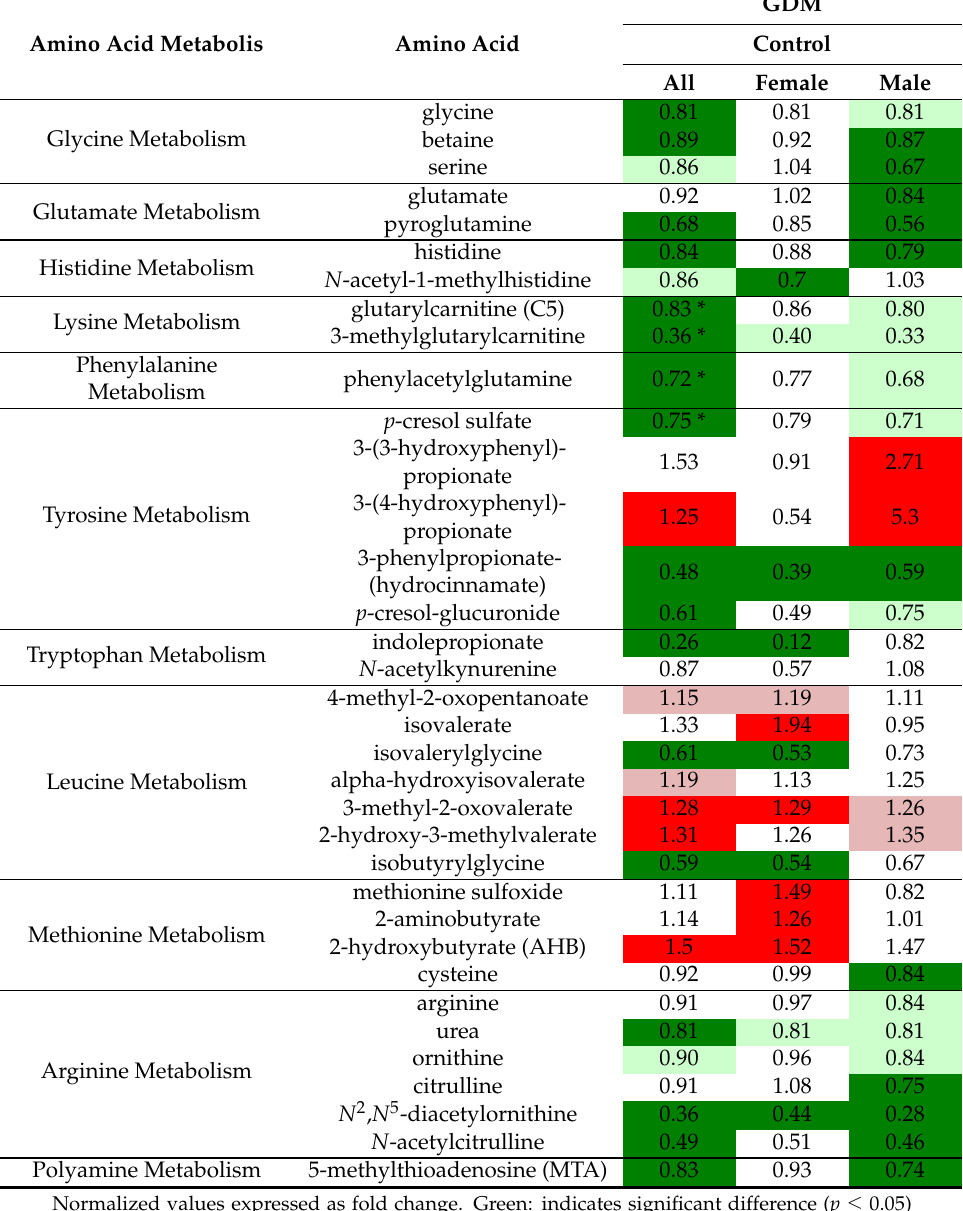
Table 3. Changes in amino acid metabolism in second trimester AF of women with GDM.